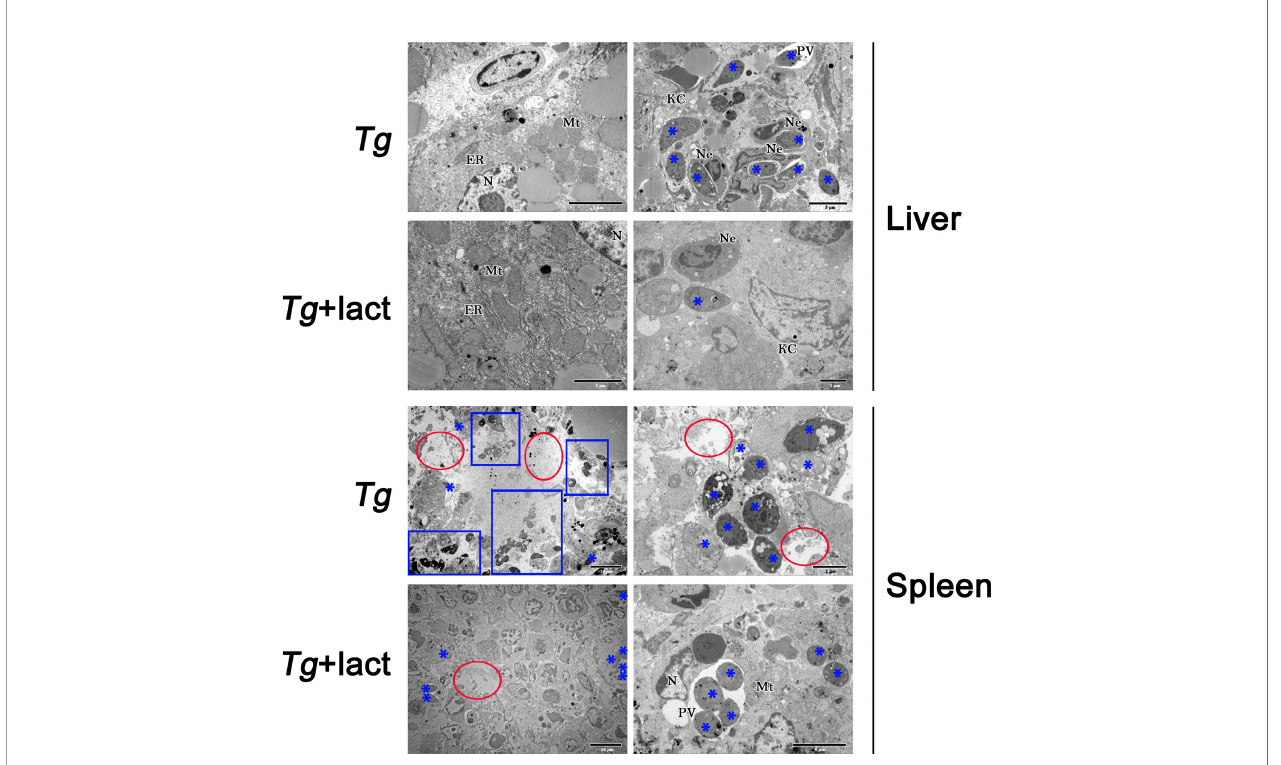
FIGURE 3 | The ultrastructure of the livers and spleens in T. gondii -infected mice with or without a -lactose treatment. Blue stars indicate T. gondii tachyzoites, blue rectangles indicate the accumulation areas of tachyzoites, and red circles indicate the large necrosis areas. N, nucleus; ER, endoplasmic reticulum; Mt, mitochondrion; Ne, neutrophil; KC, Kupffer cell; PV, parasitophorous